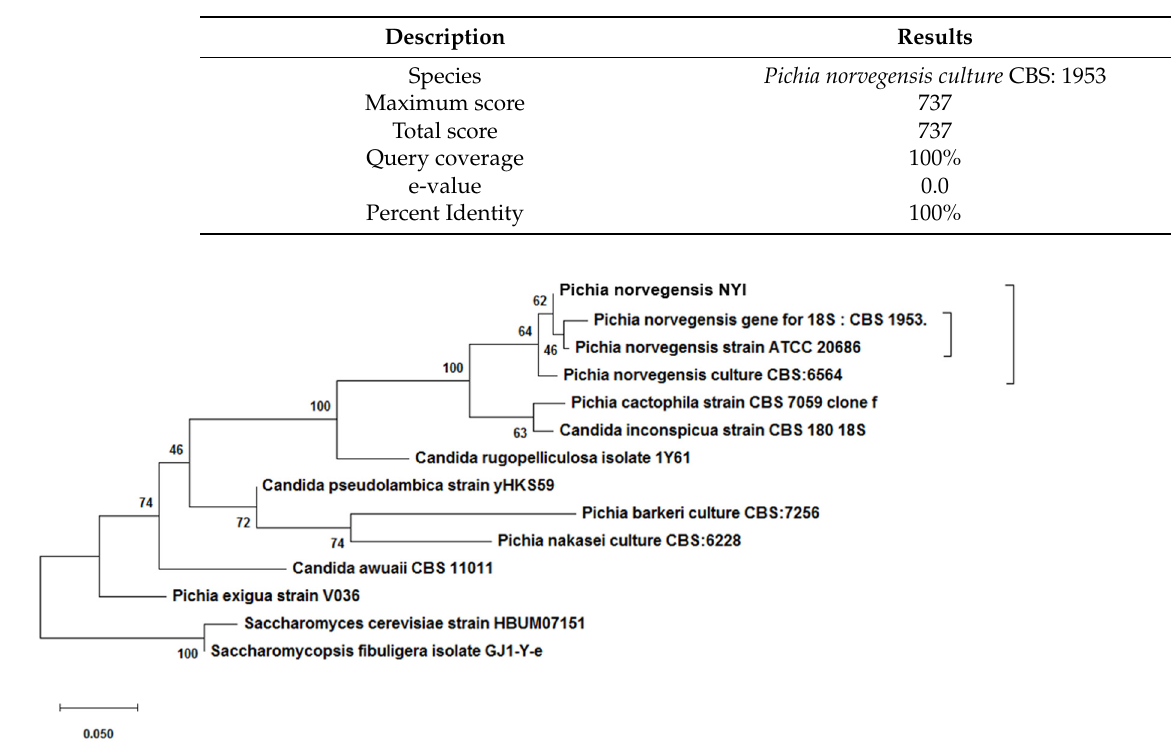
Figure 2. Phylogenetic tree of Pichia norvegensis NYI.